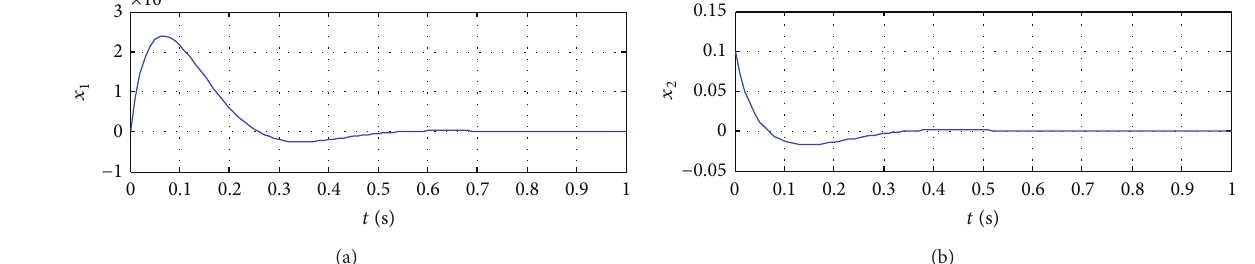
Figure 5: Response of system to initial condition with minimum-order